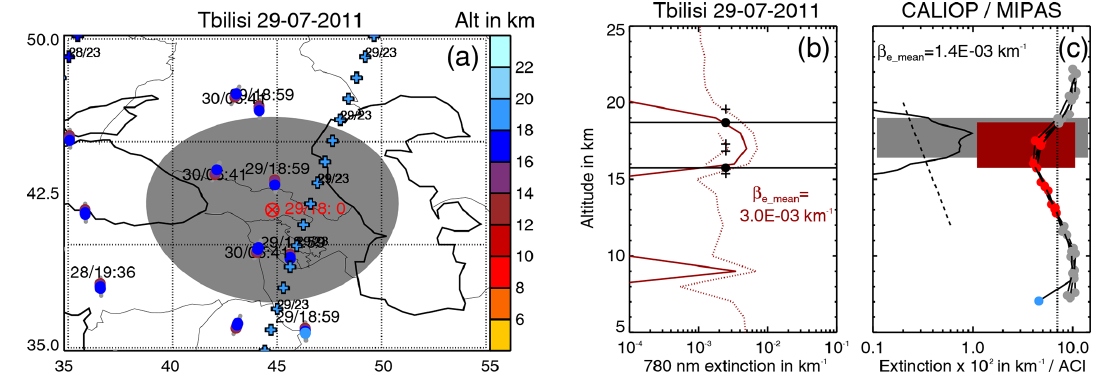
Figure 14. Measurements of Nabro aerosol over Tbilisi on 29 July 2011. (a) Map with the twilight station, match radius, MIPAS and CALIPSO orbits, their measurement times, and the MIPAS (circles) and CALIOP (crosses) cloud top heights (colour coded). (b) Twilight extinction profile at 780nm (red solid line) and uncertainty (red dotted lines). The black circles indicate the aerosol layer top and bottom altitude and the black crosses indicate the altitude uncertainty range. (c) CALIOP extinction (black solid line) and MIPAS ACI profiles (black lines with coloured circles). For the CALIOP profile the black dashed line indicates the extinction threshold and the grey box is the aerosol layer derived from CALIOP. For the MIPAS profiles grey dots denote clear air, red dots sulfate aerosol, and blue dots denote ice and optically thick clouds. The black dotted line is the ACI threshold of 7. The red box denotes the aerosol layer detected by the twilight measurement.